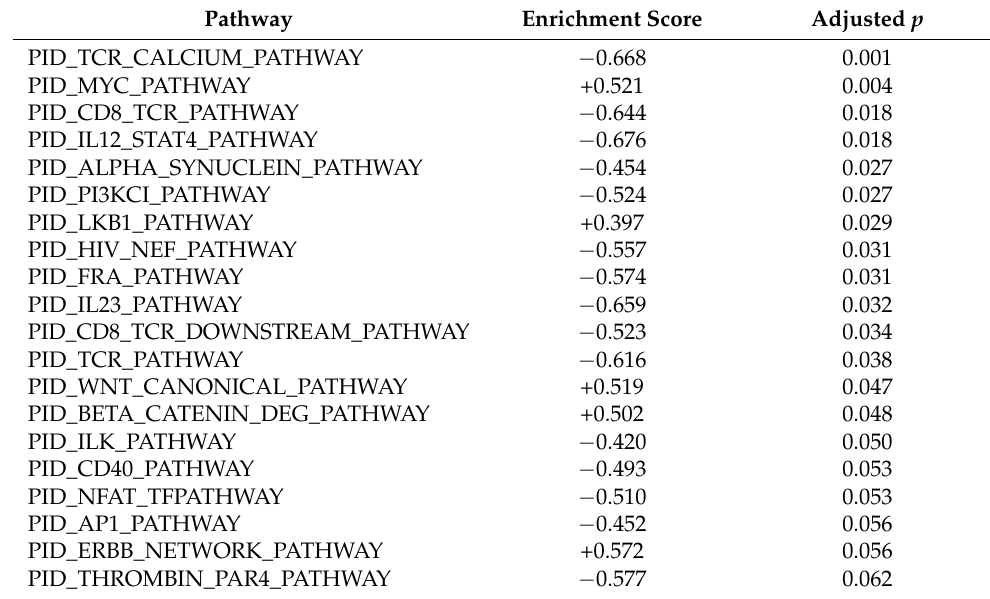
Table 4. Top 20 Pathway Interaction Database (PID) pathways associated with expression loss of the sodium iodide